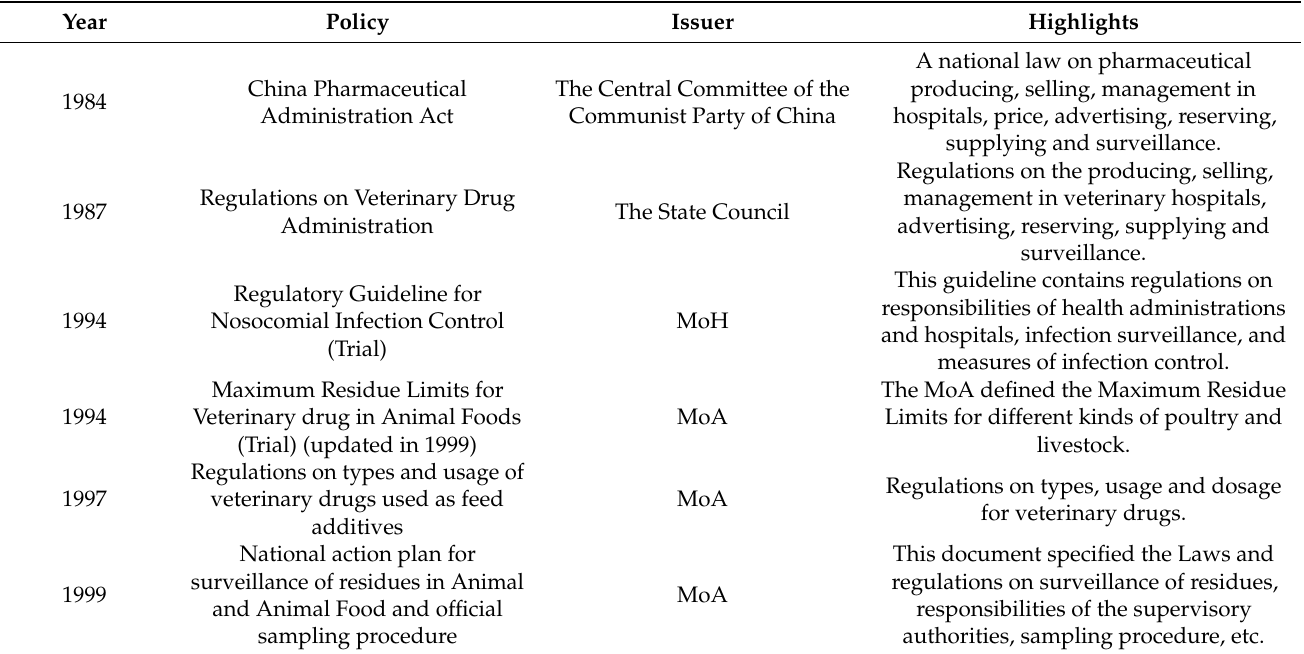
Table 1. Policy and regulation milestones on AMR control in China at stage